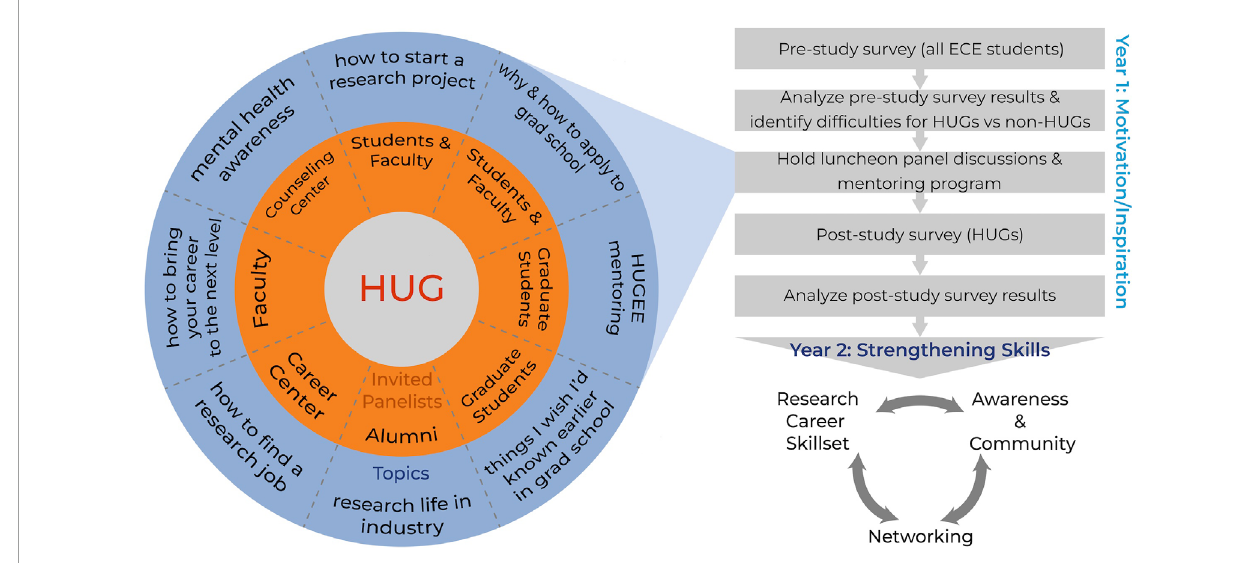
FIGURE 2 Diagram for HUG Initiative makeup and